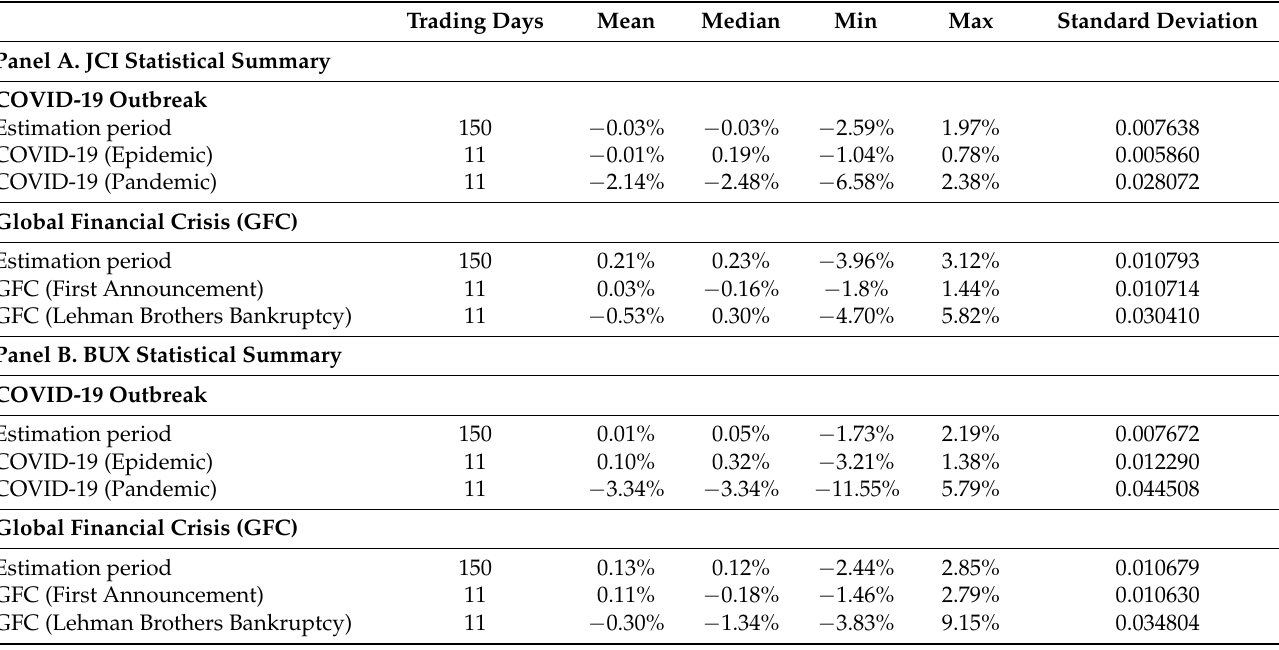
Table 2. Statistical summary of Actual Return for JCI and BUX return